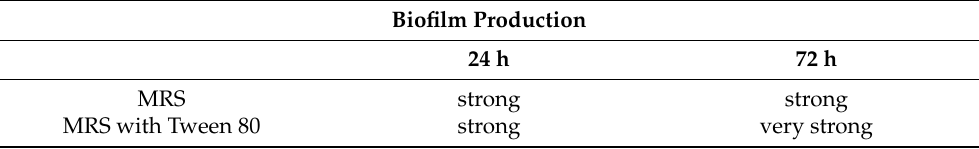
Table 6. Ability of the L. rhamnosus CA15 (DSM 33960) strain to produce